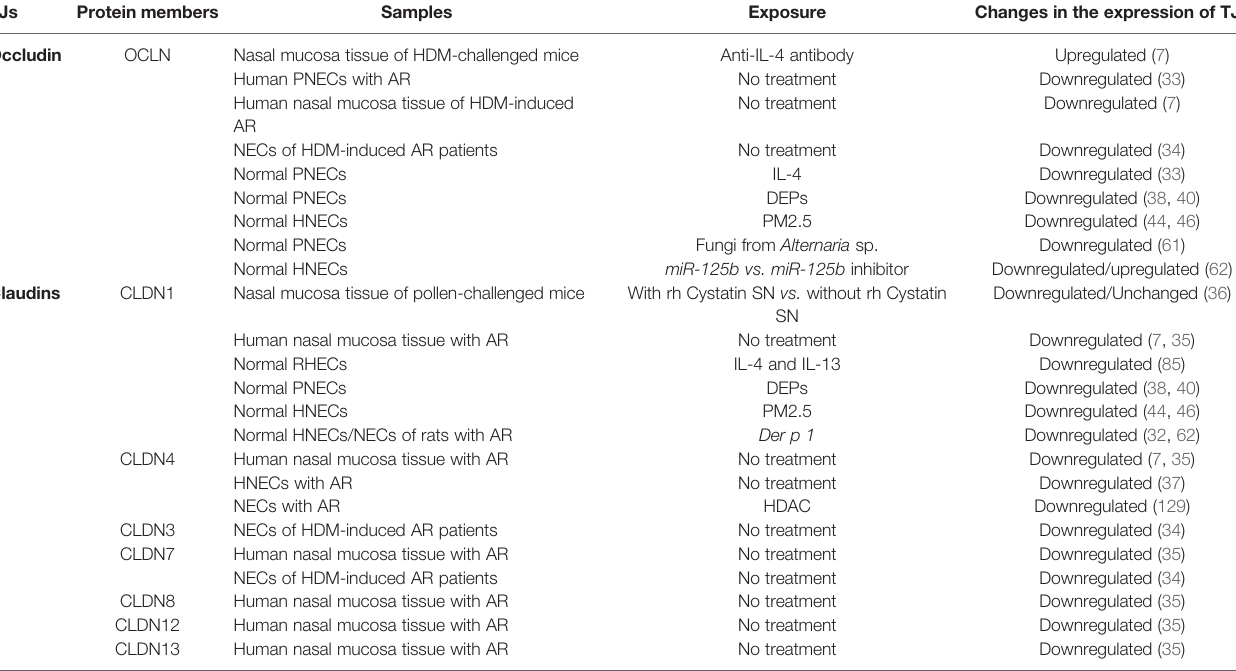
TABLE 1 | TJ molecules expression in AR patients versus normal subjects, or in murine AR models.